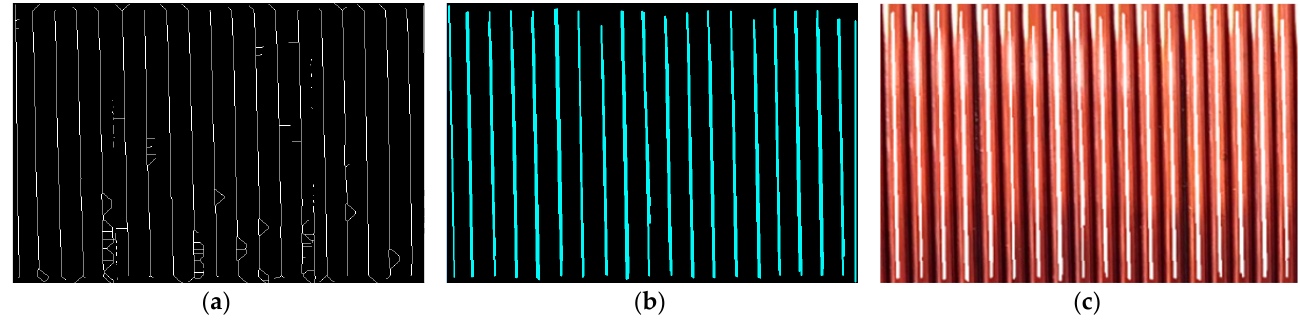
Figure 11. Skeleton extraction results: ( a ) skeleton image, ( b ) Hough line detection, ( c ) The effect of the skeleton on the original image.